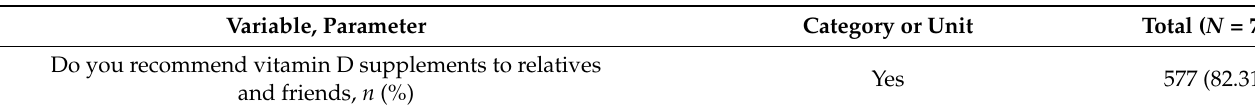
Table 5. Practice in vitamin D